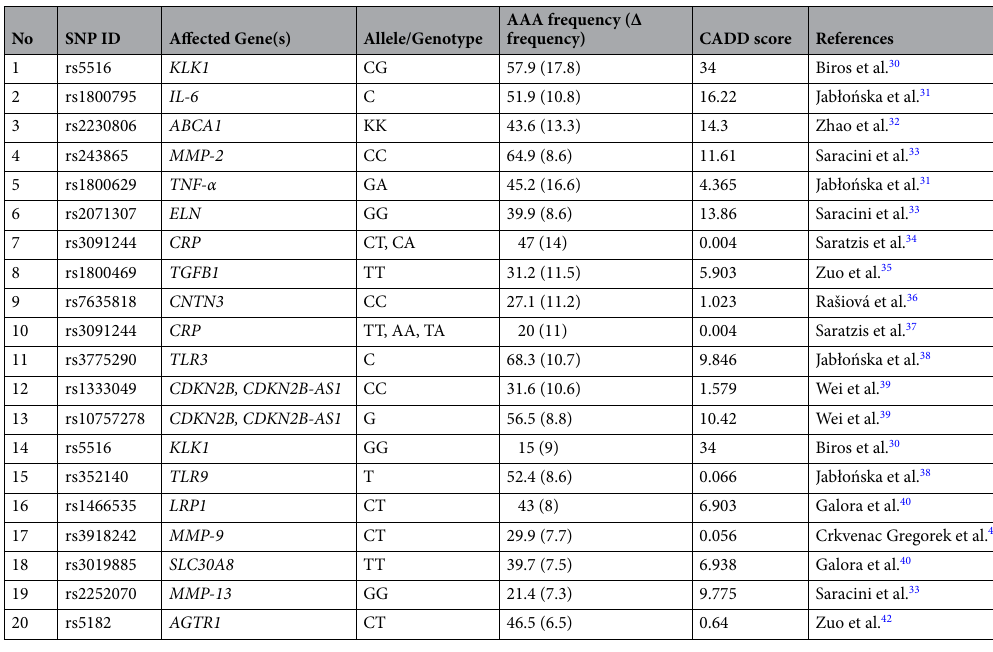
Table 2. Top 20 upregulated SNPs from the retrieved AAA gene association clinical studies. SNPs with both High CADD score and frequency are highlighted green in the table, implying their association with pathogenicity, disease severity, regulatory effects, and complex trait in AAA. KLK1, Kallikrein 1; TNF-α, Tumor Necrosis Factor Alpha; CRP, C-reactive Protein; ABCA1, ATP Binding Cassette Subfamily A Member